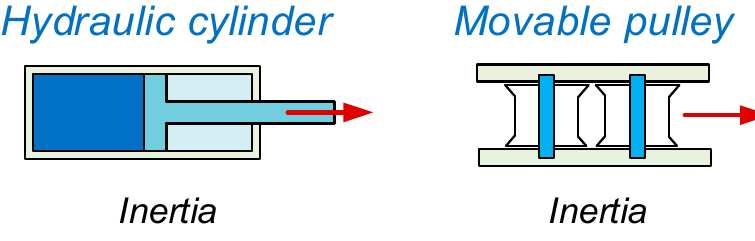
Figure 8. Inertial energy storage schematic diagram of the HTD. Figure 9. Capacitive energy storage schematic diagram of the HTD.